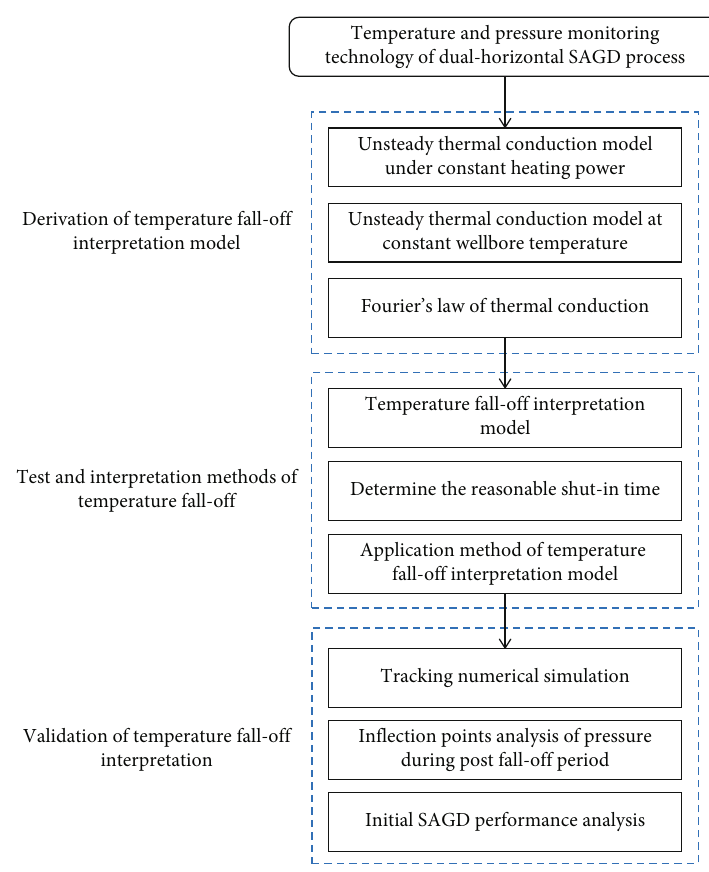
Figure 1: The fl owchart of the problem under study.